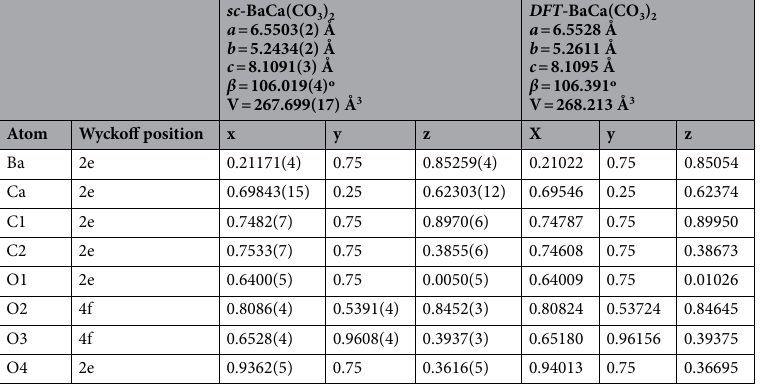
Table 1. Experimental (single-crystal, sc ) and calculated (DFT) lattice parameters and atomic coordinates of BaCa(CO 3 ) 2 barytocalcite structure at ambient conditions. The structure is described with the monoclinic P 2 1 / m space